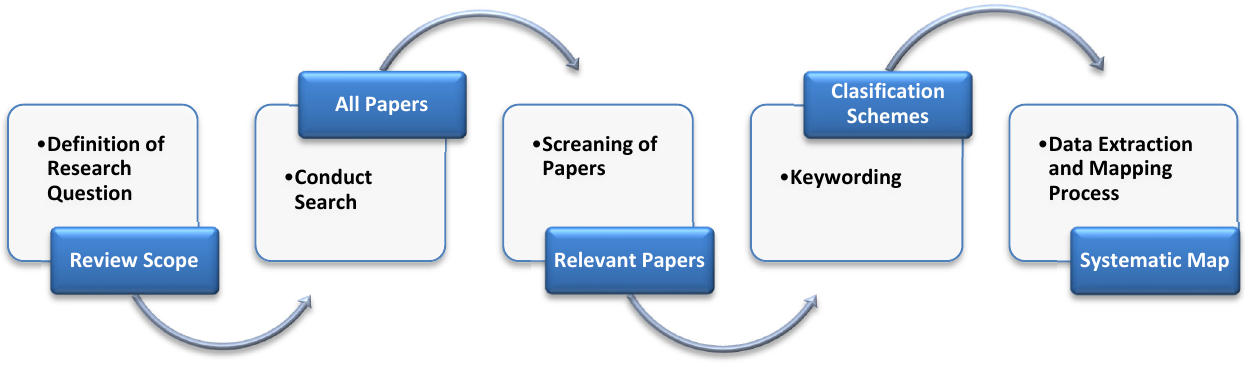
Figure 10. Systematic mapping